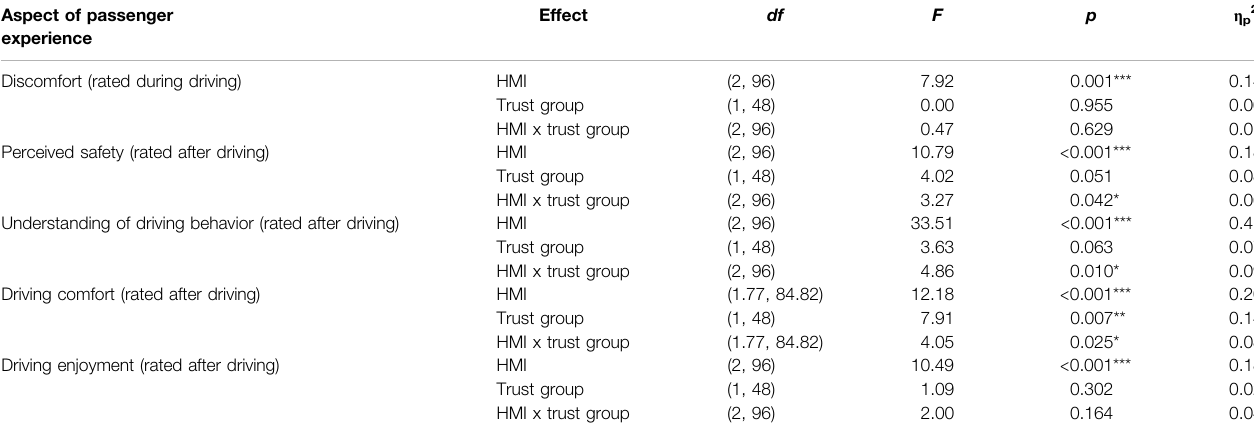
TABLE 3 | Mixed design ANOVA results on the effects of HMI condition and trust group membership on the passenger experience in automated driving. Aspect of passenger experience